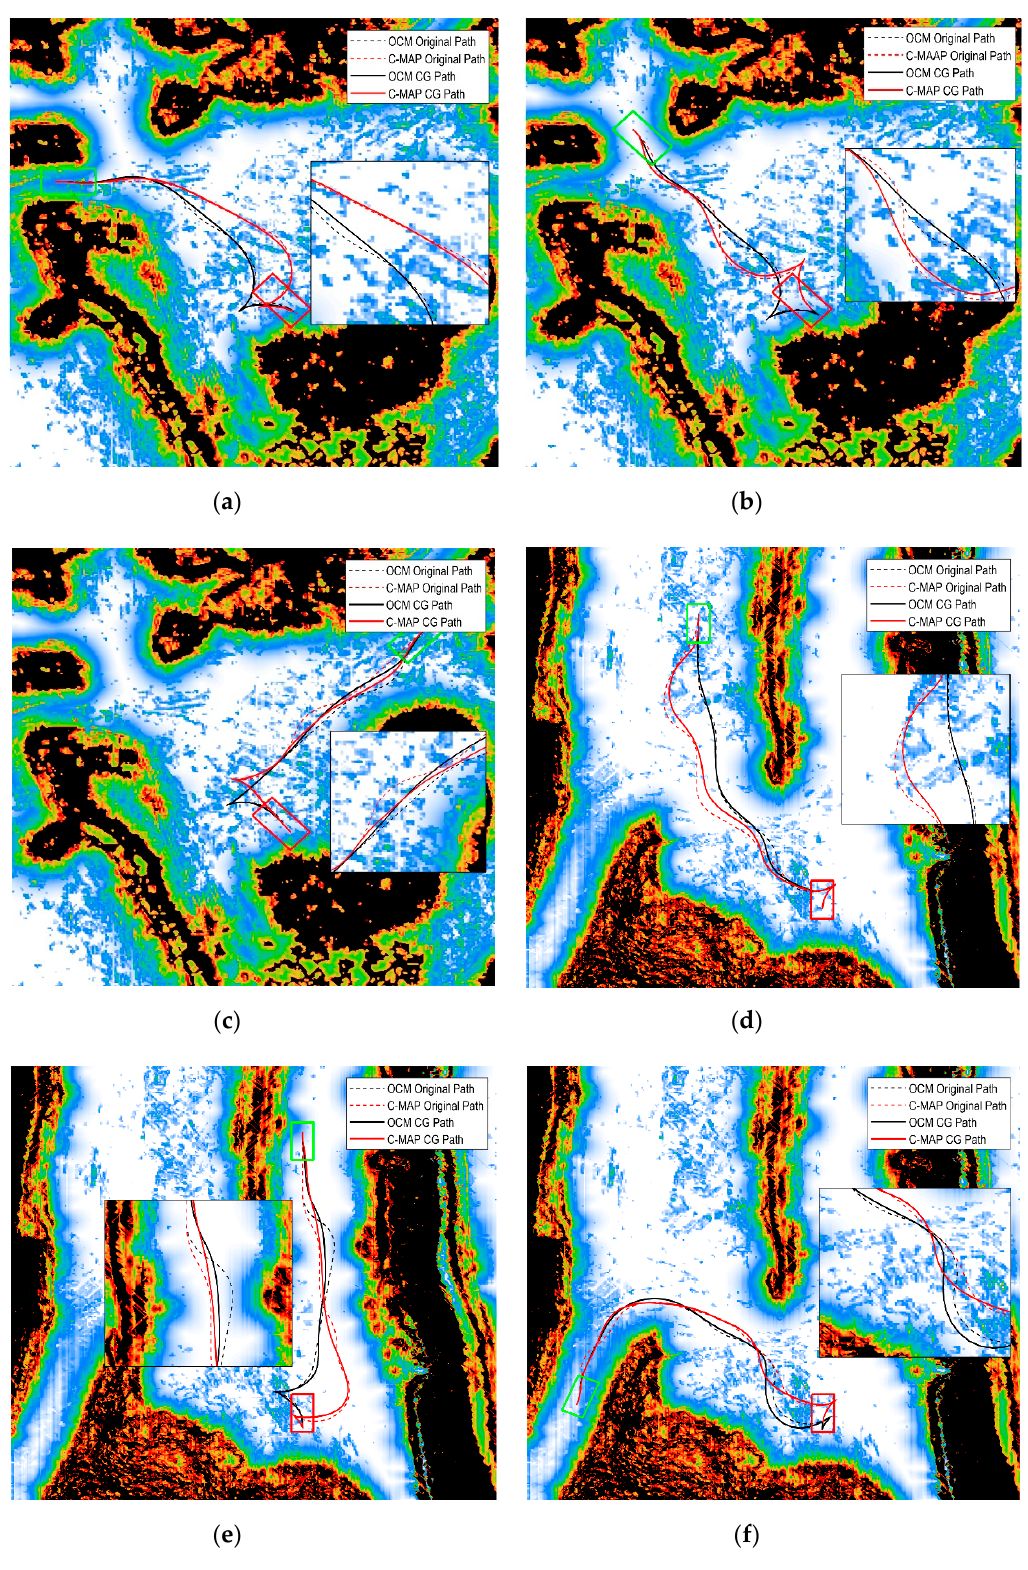
Figure 15. Verification of path planning in two scenes. ( a – c ) are the path planning experiments in scene 1; ( d – f ) are the path planning experiments in scene 2.The black line represents the path planned in OCM, and the red line represents the path planned in C-MAP. The dotted line is the path without CG optimization, and the solid line represents the path after CG